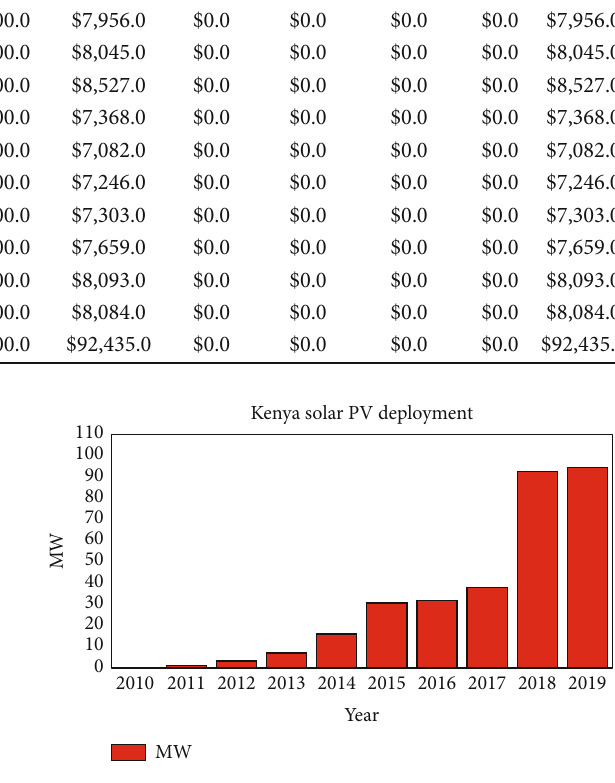
Figure 14: Solar PV trends in Kenya by